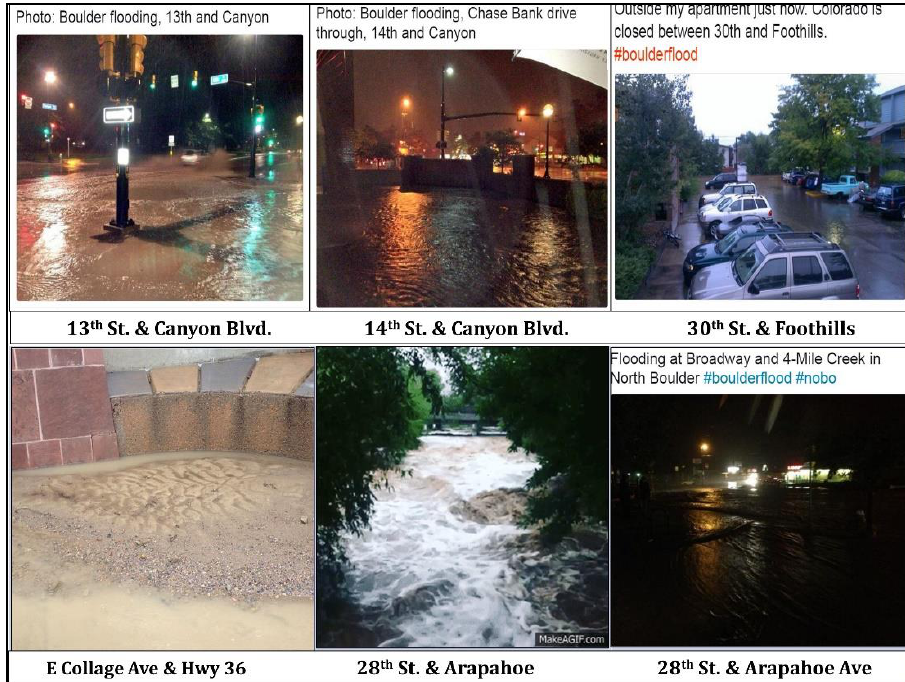
Figure 4. Images of flooded streets.